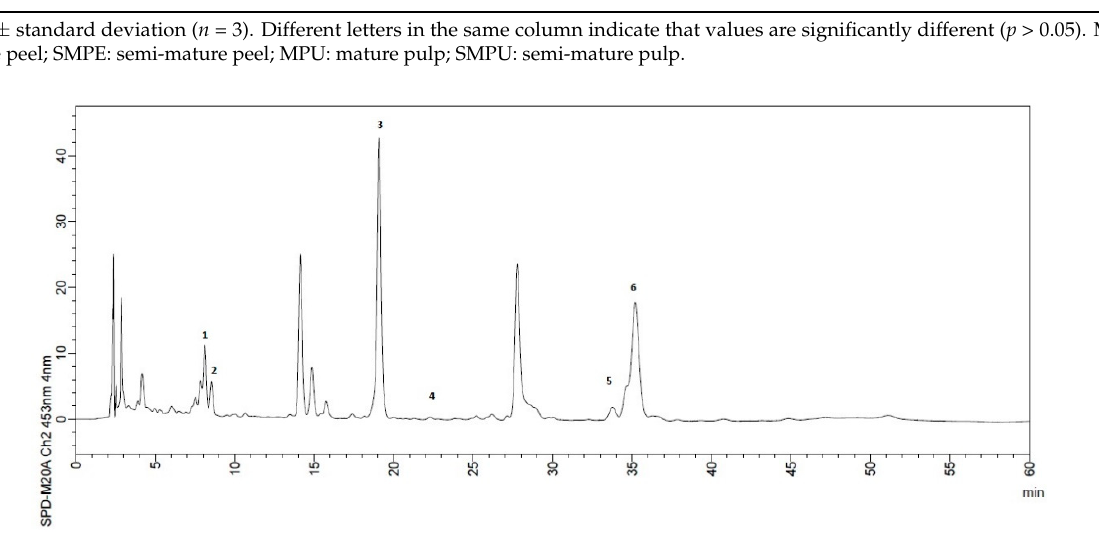
Figure 3. Typical chromatogram for carotenoids: 1. Lutein; 2. Zeaxanthin; 3. beta-cryptoxanthin; 4. alfa-tocopherol; 5. alfa-carotene; 6. beta-carotene.